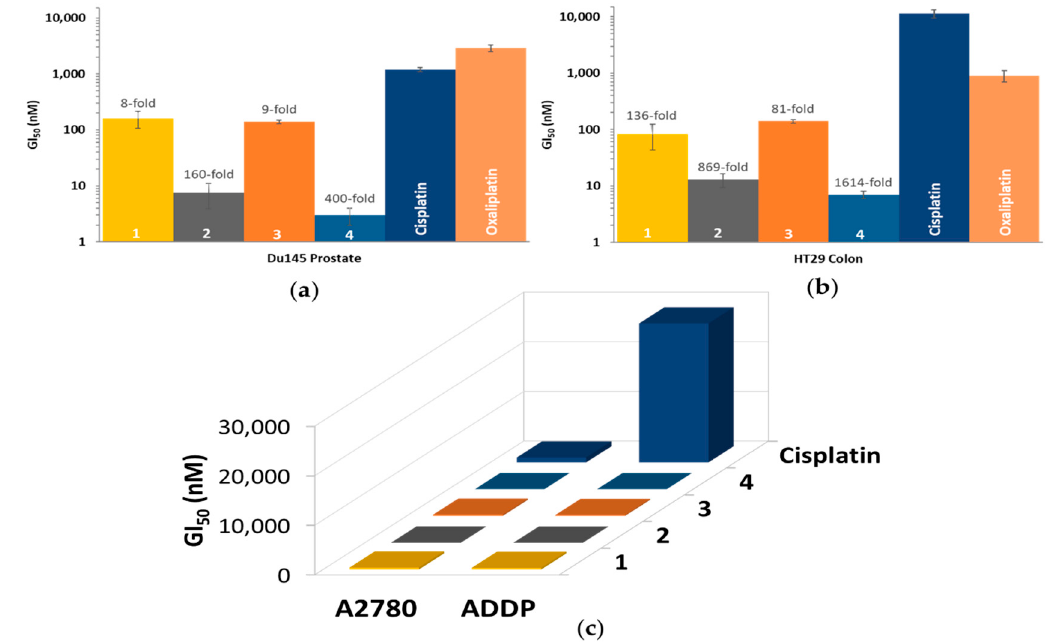
Figure 7. ( a ) and ( b ): The GI 50 values of 1 – 4 , cisplatin and oxaliplatin in the Du145 prostate ( a ) and HT29 colon ( b ) cancer cell lines, with the (number)-fold potency of 1 – 4 compared to cisplatin; ( c ) The GI 50 values of 1 – 4 and cisplatin in the A2780 (ovarian) and ADDP (cisplatin-resistant ovarian) cancer cell lines. Complexes were incubated for 72 h; GI 50 values (nM) are the mean and reported with standard error of the mean; results are produced from three independent experiments.